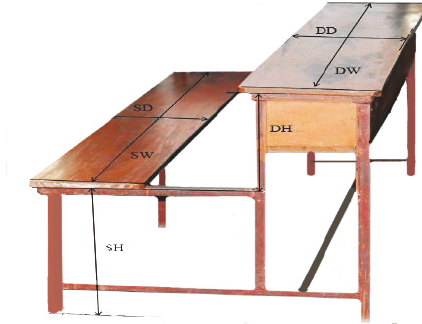
Figure 2: Representation of classroom furniture measurements. SD = seat depth, SW = seat width, SH = seat height, DH = desktop height, DW = desktop width, and DD = desktop